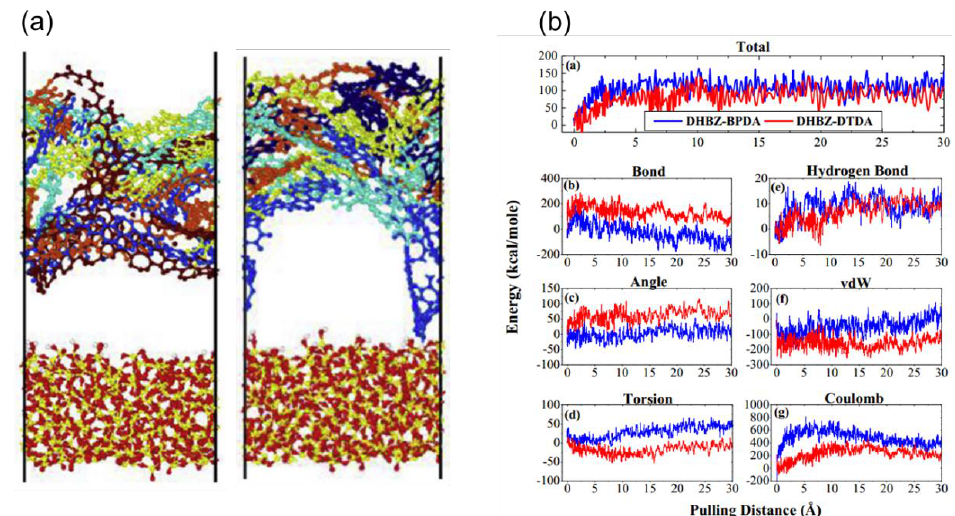
Figure 5. ( a ) Snapshots for deformation of polyimide chain: DHBZ–BPDA (left) and DHBZ–DPDA (right). ( b ) Decomposition of energy terms and their evolution as a function of pulling distance (reprinted from Reference [26], Copyright 2016, with permission from Elsevier).